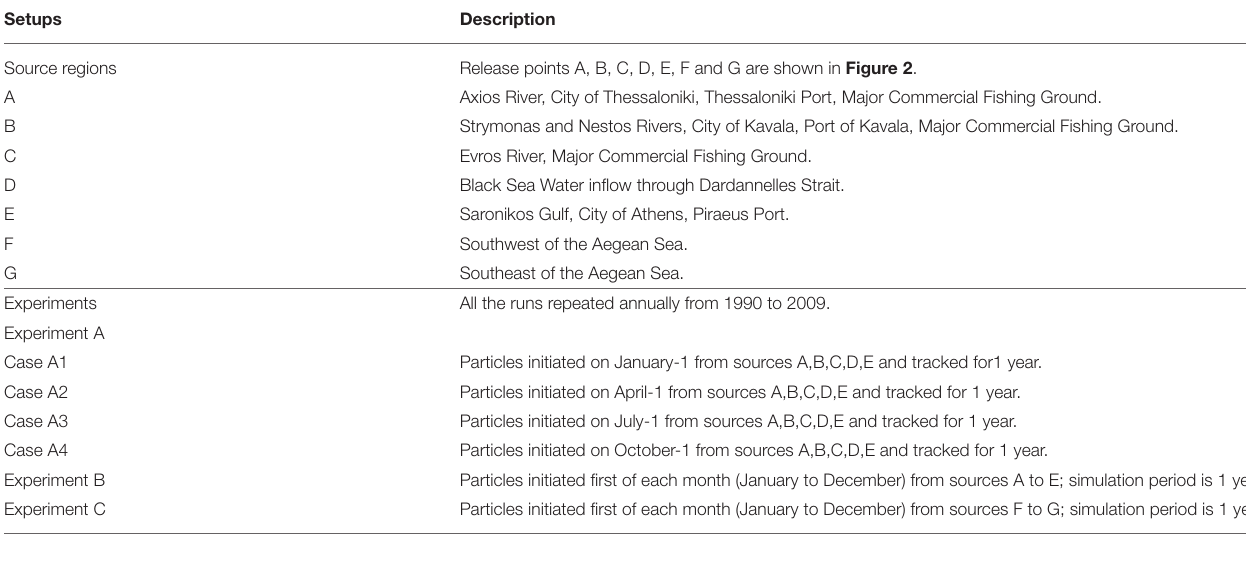
TABLE 1 | Model setup describing source regions and experiments. Setups Description